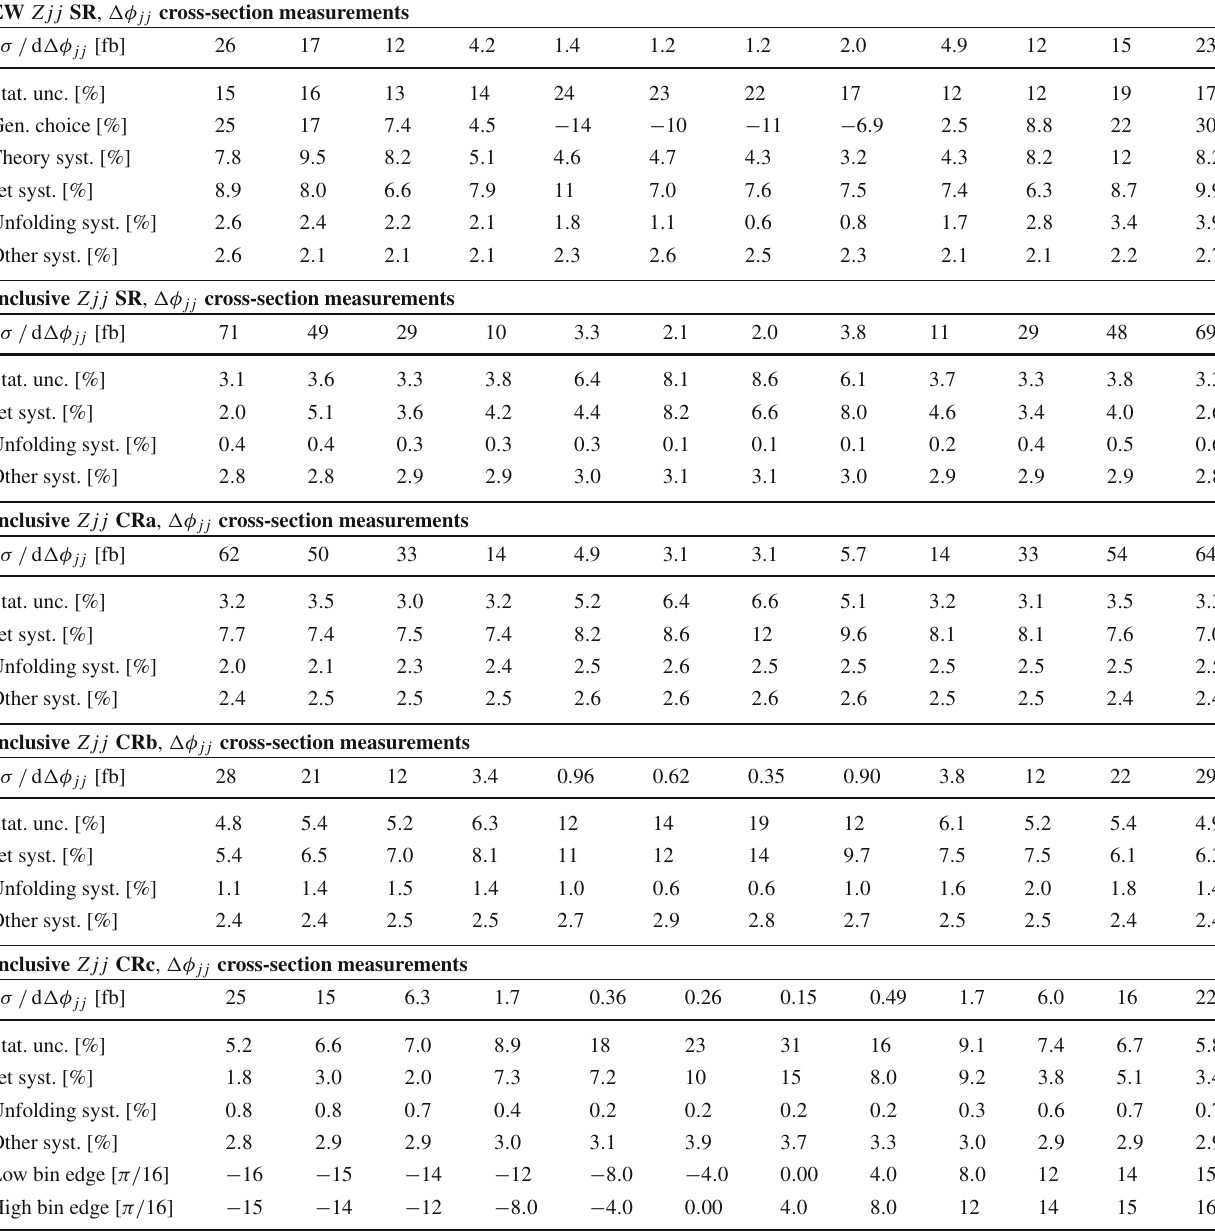
Table 8 Differential cross-section measurements for EW Zjj production and inclusive Zjj production as a function of (cid:4)φ jj . The EW Zjj measurements are performed in the signal region. The inclusive Zjj measurements are performed in the signal region and three control regions. The different sources of uncertainty are grouped together for each measurement, with a more granular breakdown of each uncertainty available in HEPDATA EW Zjj SR , (cid:4)φ jj cross-section